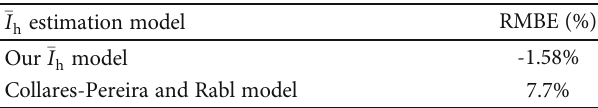
ð I / I Þ and the clarity d d h